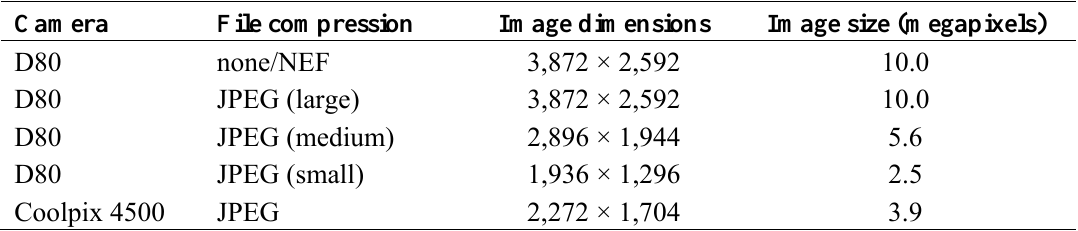
Table 2. List of image types collected at each forest site, using both cover and full-frame fisheye